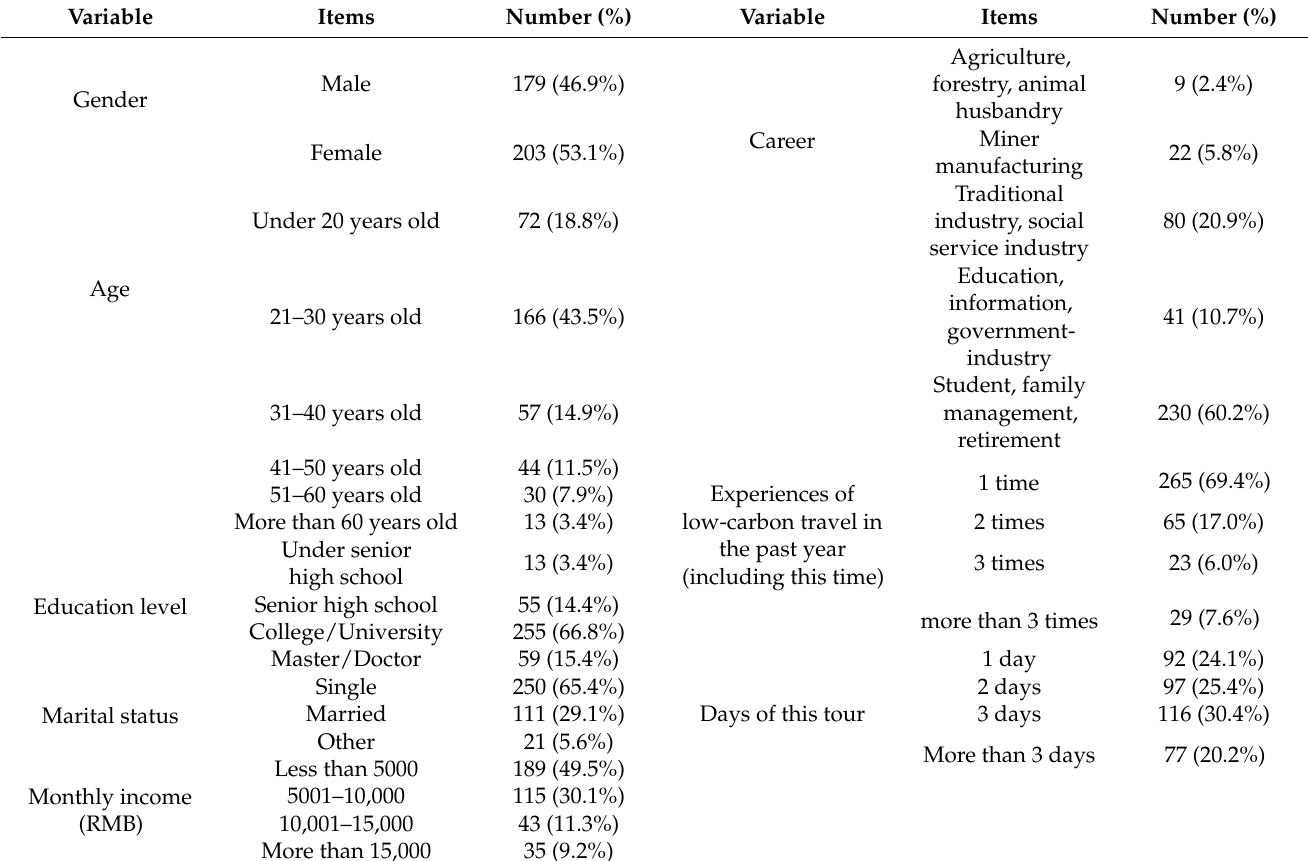
Table 1. The first sample’s profile and travel characteristics—from low-carbon destinations ( n =